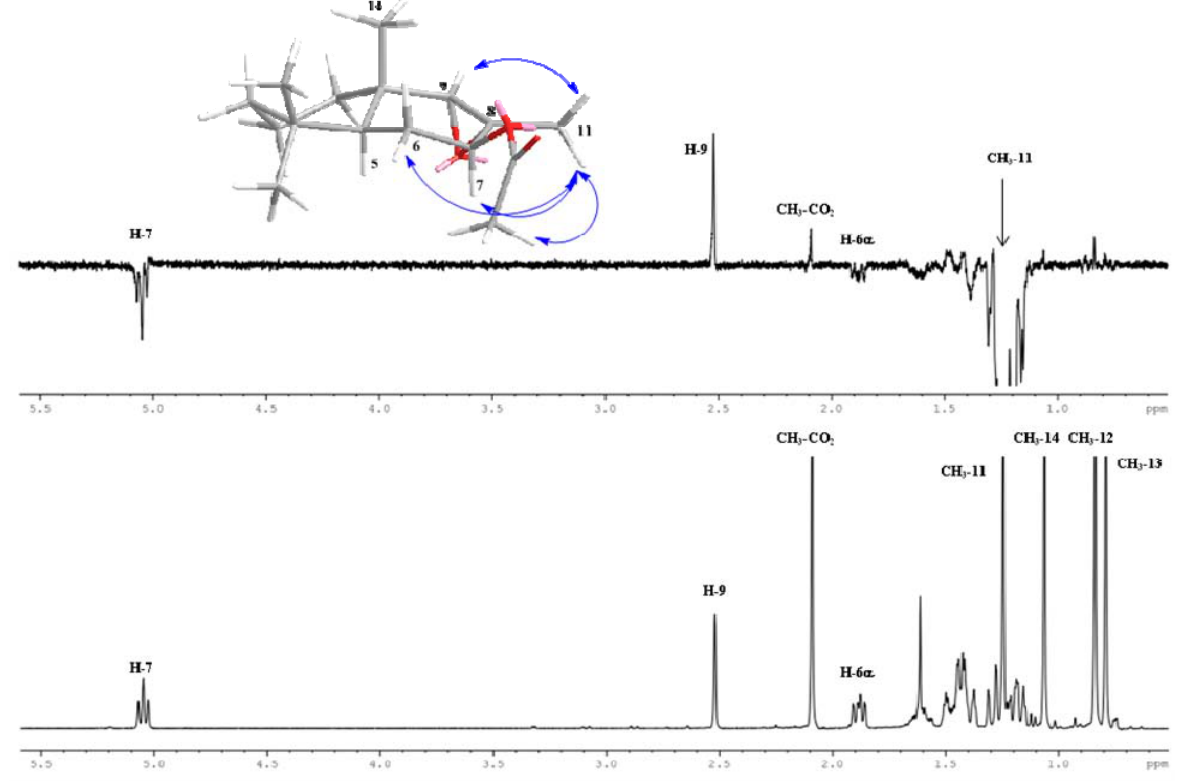
Figure 2. Bottom: 1 H-NMR spectrum of compound 12 . Top: 1D 1 H sel. gs NOESY experiment ( selnogp pulse program from Bruker Library) showing the main long-range interactions between CH -11 and H-9, and CH CO-9. Three spins NOE effect was also 3 3 observed between CH -11 with H-7 and H-6  (in negative 3